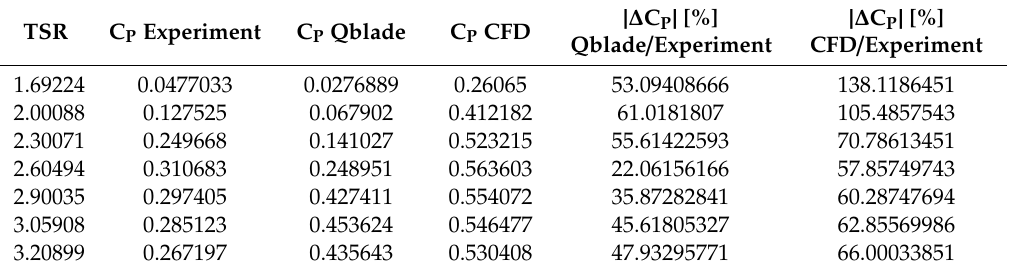
Table 2. Comparison of C P from experiment, CFD, Qblade and their relative deviation.